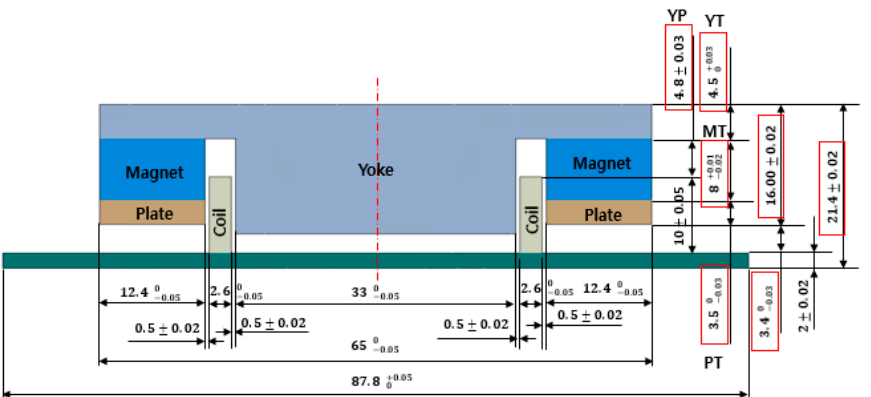
Figure 27. Comparison of reliability of magnetic thickness minimization for design tolerance of vertical magnetized structure.